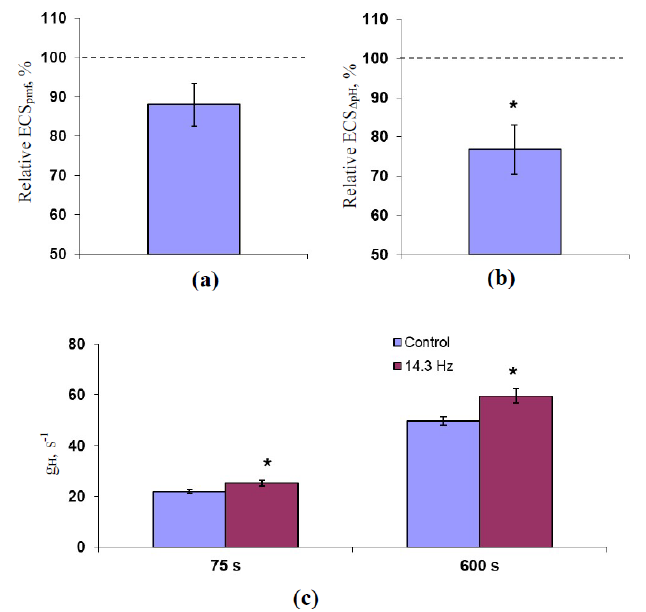
Figure 4. Influence of extremely low-frequency magnetic field (ELFMF) with 14.3 Hz frequency and 18 µ T magnitude on relative values of the proton motive force (ECS pmf ) ( a ), proton gradient (ECS ∆ pH ) ( b ), and H + conductivity ( c ) across the thylakoid membrane ( n = 6). Measurement of the electrochromic shift (ECS) was initiated after 15 min of dark adaptation. ECS pmf and ECS ∆ pH were calculated on basis of different components of ECS after 600 s of the illumination; relative values under the ELFM treatment were calculated as a percentage from the same control values. g H was calculated as the exponential velocity of the ECS relaxation after 75 and 600 s of illumination. The ECS measurement and analysis is described in Section “Materials and Methods” in more